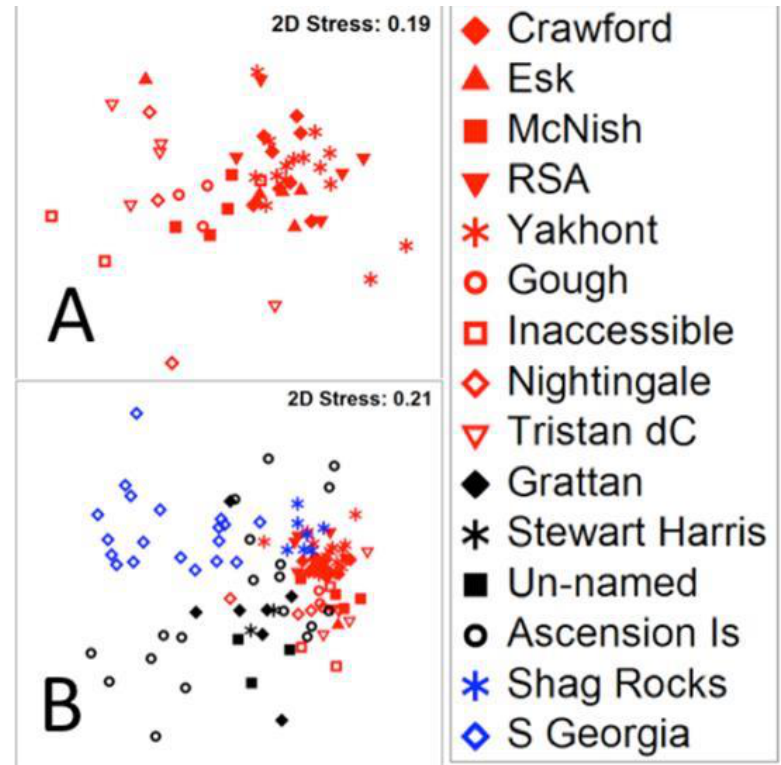
Figure 4. Similarity in benthic assemblage structure at <1000 m on the seabed around Tristan da Cunha ( A ) and compared with remote comparison sites ( B ). The symbols are named seamounts (solid) and islands (open), temperate (red), tropical (black) and polar (blue). Tropical and polar data [25,26]. Inaccessible whereas Yakhont was distinct from islands apart from Gough (Table 2), of which both islands were similar distances away to both seamounts. Table 2. One way ANOSIM on assemblage differences between localities in the Tristan da Cunha region. Pairwise values shown are ANOSIM R, in which significance is <0.01 (*) and <0.001 (**). R close to zero means little pairwise difference whereas R nearing 1 is highly different. Non significant pairwise comparisons are shown with an ‘x’. Locality Yakhont Crawford McNish RSA Gough Tristan